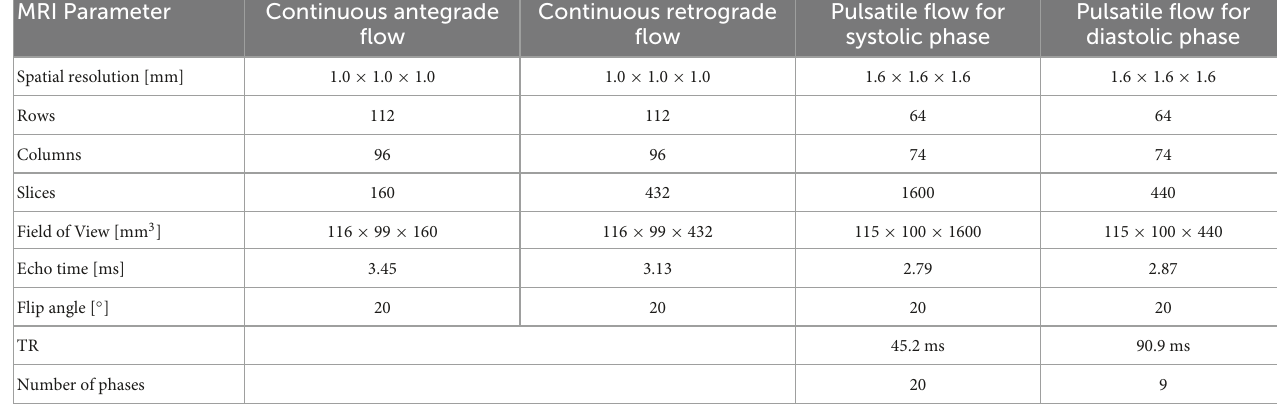
TABLE 3 MR acquisition setting used for continuous antegrade and retrograde flow as well as for pulsatile systolic and diastolic flow.